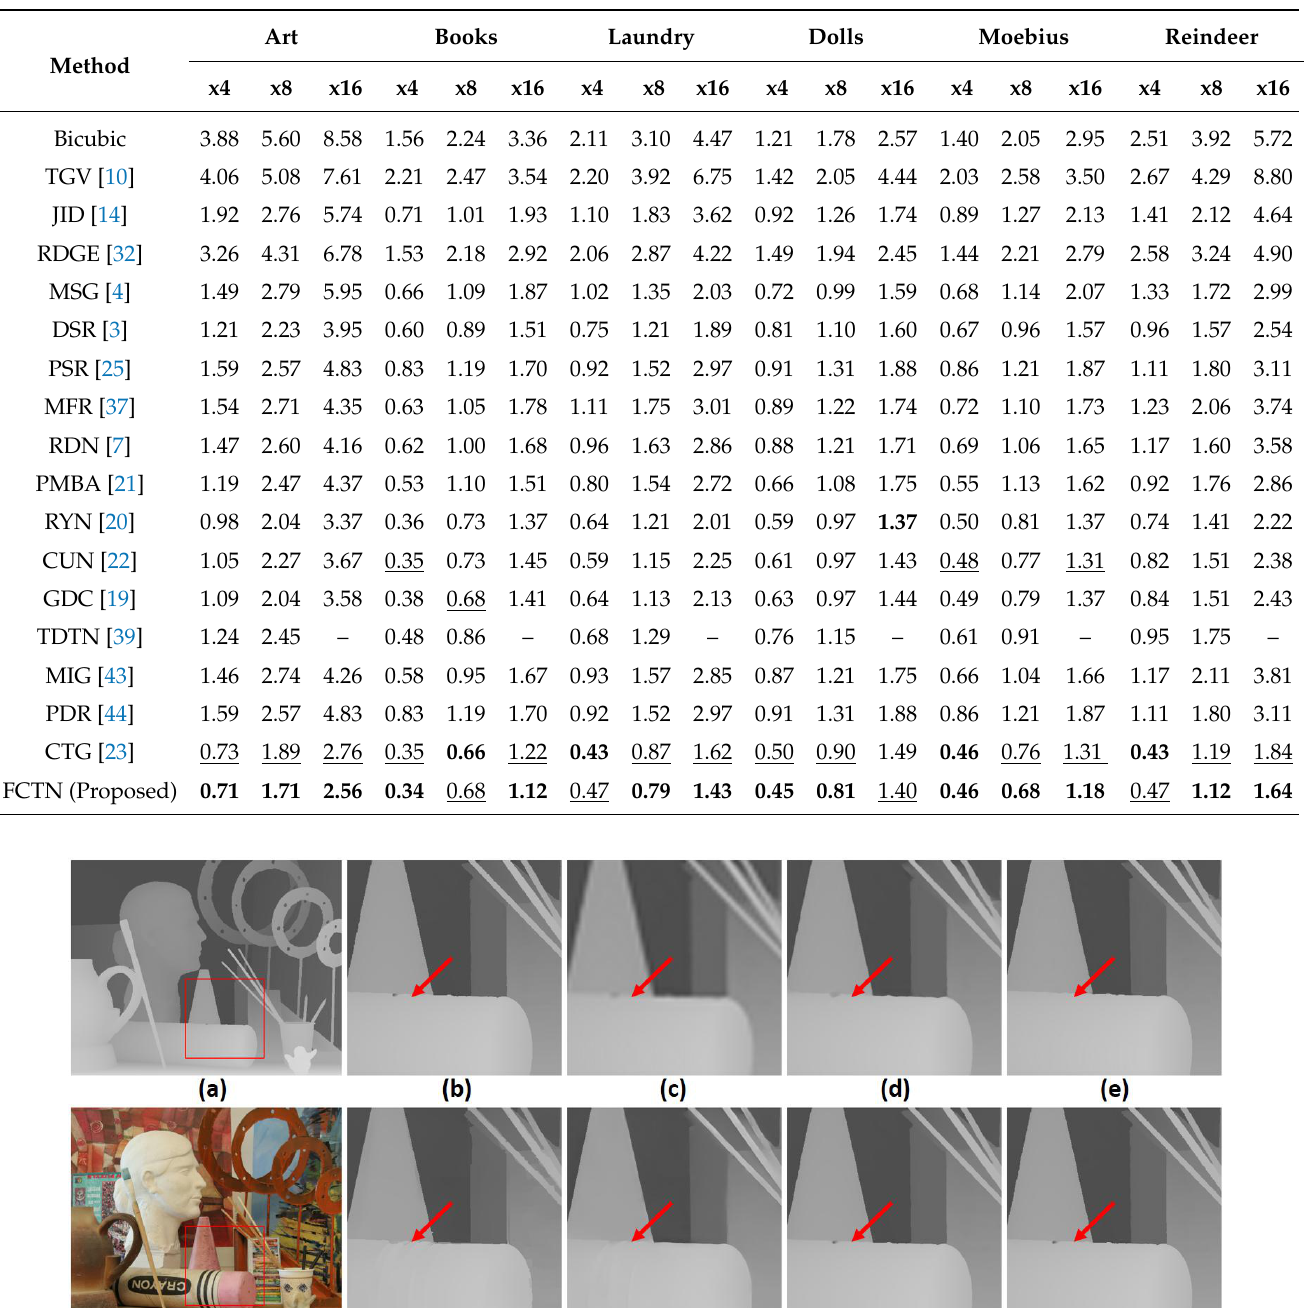
Table 1. An analysis of RMSE Values for different scaling factors on the noise-free Middlebury dataset. Boldface indicates the best RMSE for each evaluation, while the underline indicates the second best.